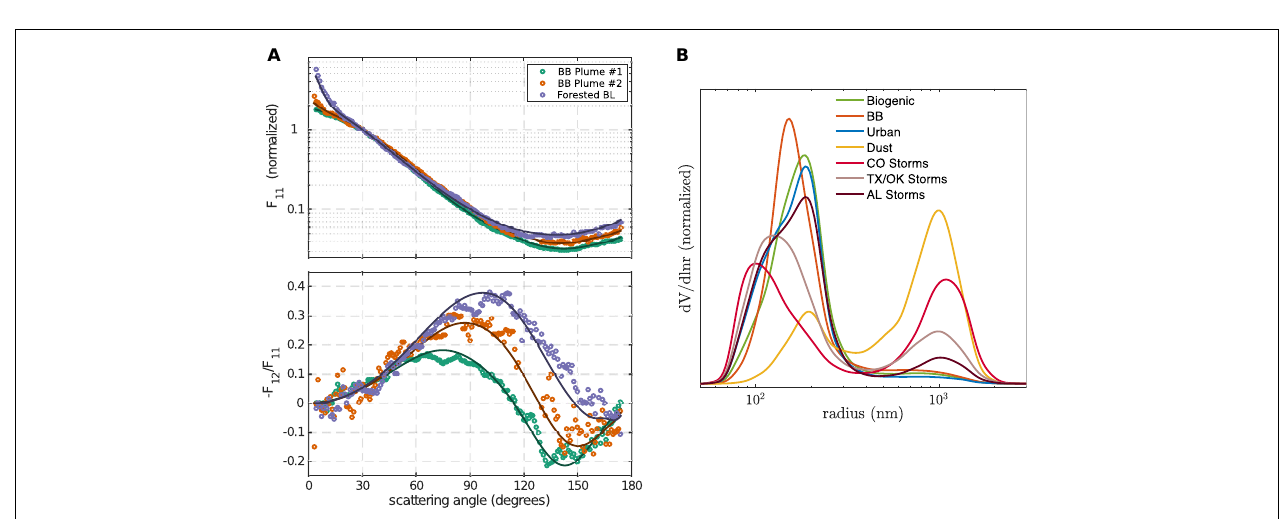
FIGURE 9 | Spectral mass absorption efficiency (m 2 /g) for Saharan dust (A) and volcanic ash (B) , measured as a continuous spectrum from 300 to 2350 nm. The sampled particles were size separated into a fine mode ( < 1 µ m: red) and all sizes (blue). Panels taken from Rocha-Lima et al. (2014, Figure 8) and Rocha-Lima et al. (2018, Figure 7).